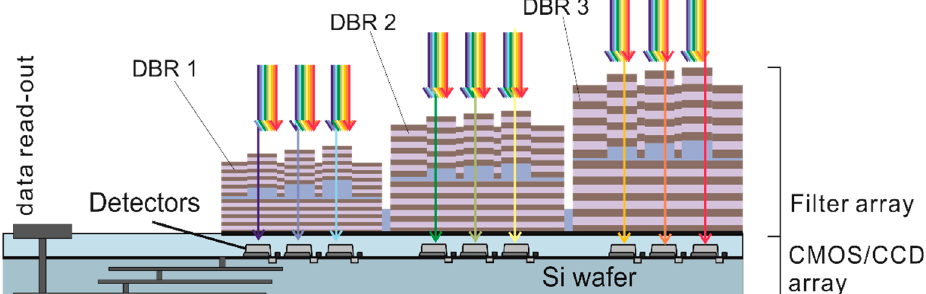
Figure 5. Cross section a nanospectrometer combining three different, spectrally neighbored DBRs in an FP filter array with a sensor array in CMOS or CCD technology. The definition of the blue cavity layer is achieved in just one nanoimprint step. The inclusion of nanoimprint for this sensor provides the term nanospectrometer, which we introduced for this sensor device. Shown here is the first option, namely by placing the FP filter array directly on the photodetector array including the processing integrated electronics. Reprinted with permission from ref. [11]. Copyright 2021 MDPI.